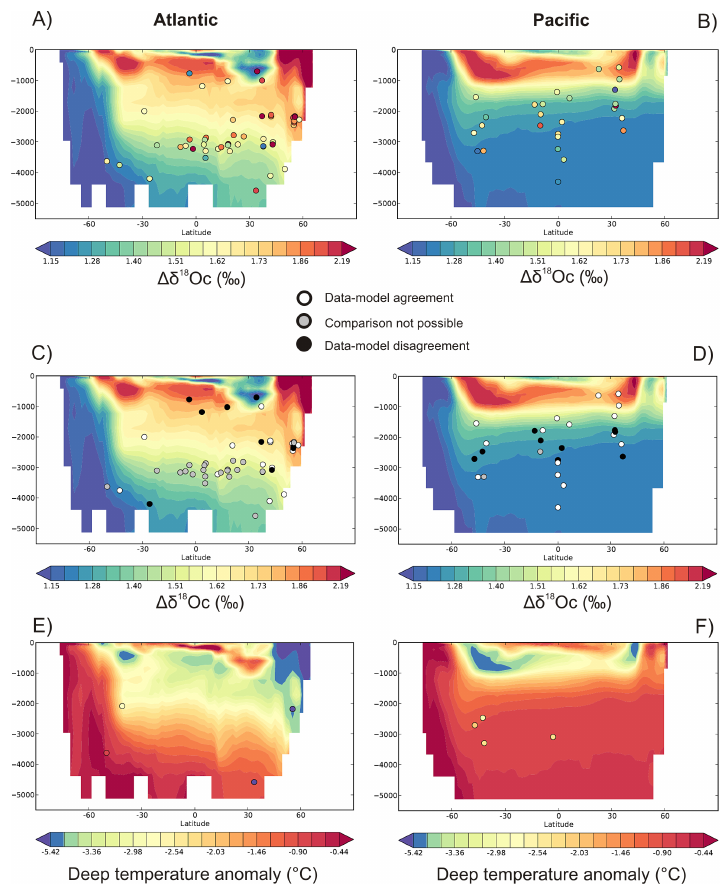
Figure 13. Atlantic and Pacific zonal mean anomaly (LGM-CT) for (a) Atlantic and (b) Pacific simulated deep ocean calcite δ 18 O in i LOVECLIM and global benthic foraminifera data (Table S2); (c) and (d) same as (a) and (b) but taking into account the uncertainties on calcite δ 18 O data (2 σ) . Grey points (comparison not possible) denote the absence of error bars on data or denote locations where model results are not comparable to data (coastal sites). (e) and (f) Simulated deep temperature in i LOVECLIM and deep temperature reconstructions for the Atlantic and for the Pacific Oceans respectively (Adkins et al., 2002; Waelbroeck et al., 2002; Malone et al., 2004; Siddall et al., 2010; Elderfield et al., 2012). For colour scale generation explanations see Fig. 1